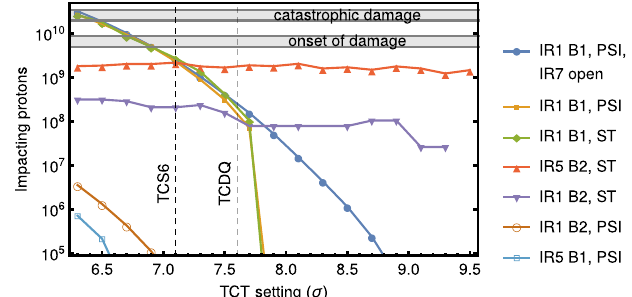
FIG. 7. The simulated losses during a single-module prefire, from PSI and S IX T RACK (ST), on TCTs in different IRs and beams for 4 TeV 50 ns operation with β (cid:1) ¼ 60 cm optics. Losses are summed over all bunches in a train and shown as a function of the TCT setting. The results are shown together with estimates of the TCT damage limits from Ref.